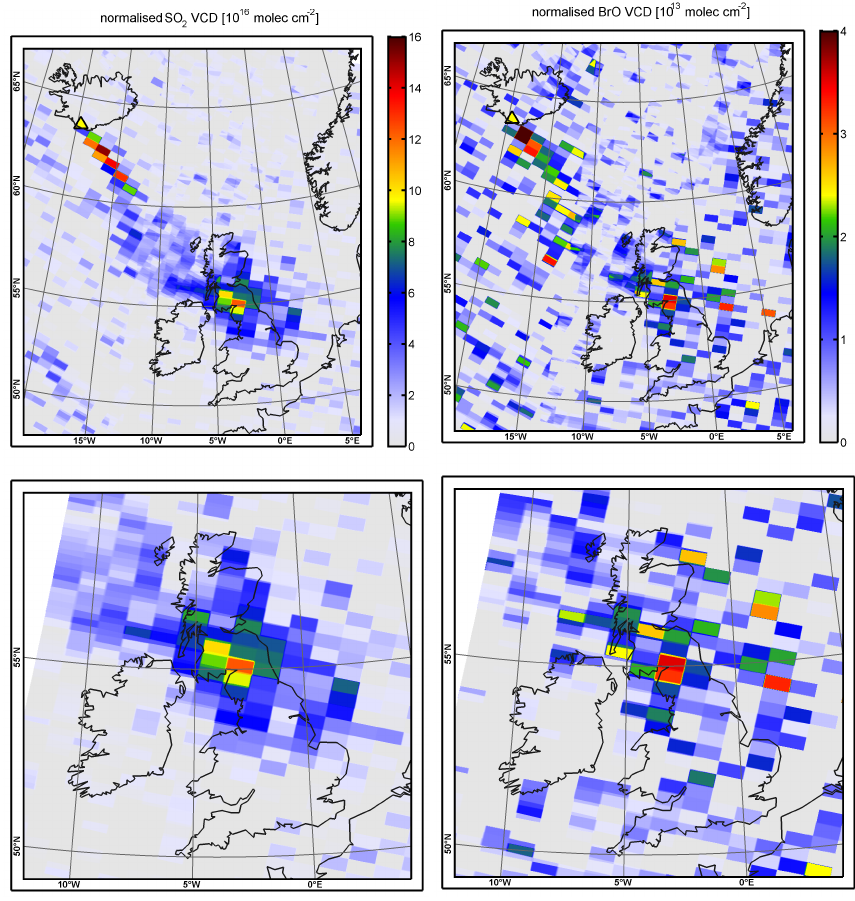
Fig. 9. GOME-2 satellite images showing SO 2 and BrO normalised geometric VCDs (Sec. 2.4) over NW Europe (top) and the British Isles (bottom) on 16 May 2010. For the overview pictures 3 orbits (3 overpasses) are shown and averaged in the overlap regions. The zoom on the British Isles only contains data of one orbit (overpass time 10:09 UTC). There are two major plumes: one is south of Iceland and another one over northern England. The CARIBIC measurements were performed north of Ireland, where a small streak of the plume is found.